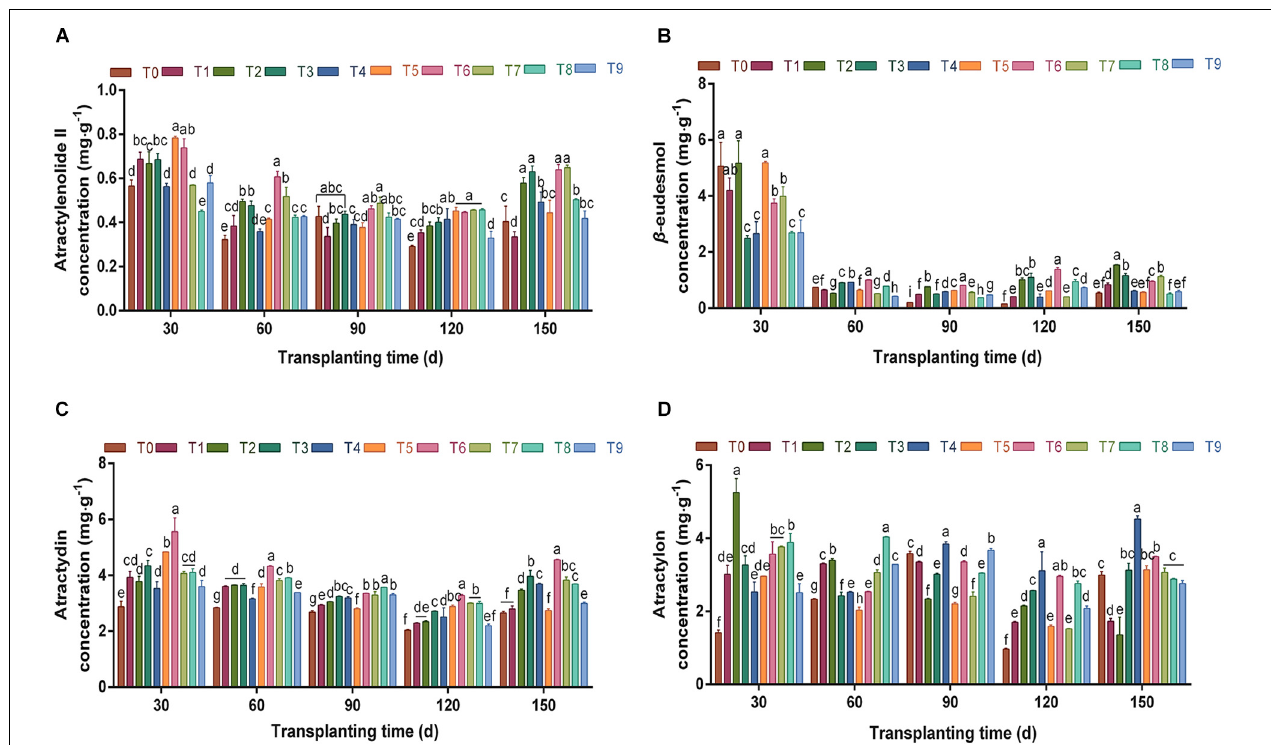
FIGURE 2 | The effects of different NPK combinations on atractylenolide II (A) , β -eudesmol (B) , atractylodin (C) , and atractylon concentration (D) in rhizomes of A. chinensis ( n = 3). (a) Initial effective component concentration of A. chinensis seedlings: atractylenolide II 0.2757 ± 0.0017 mg · g − 1 ; β -eudesmol 2.9488 ± 0.0958 mg · g − 1 ; atractylodin 2.2449 ± 0.0132 mg · g − 1 ; and atractylon 1.8074 ± 0.0421 mg · g − 1 . (b) Different lowercase letters indicate that the effects of different NPK combinations on A. chinensis were significantly different in the same period ( p < 0.05). (c) The composition of fertilization treatments: T0, N 0 P 0 K 0 ; T1, N 1 P 1 K 1 ; T2, N 1 P 2 K 2 ; T3, N 1 P 3 K 3 ; T4, N 2 P 1 K 2 ; T5, N 2 P 2 K 3 ; T6, N 2 P 3 K 1 ; T7, N 3 P 1 K 3 ; T8, N 3 P 2 K 1 ; and T9, N 3 P 3 K 2